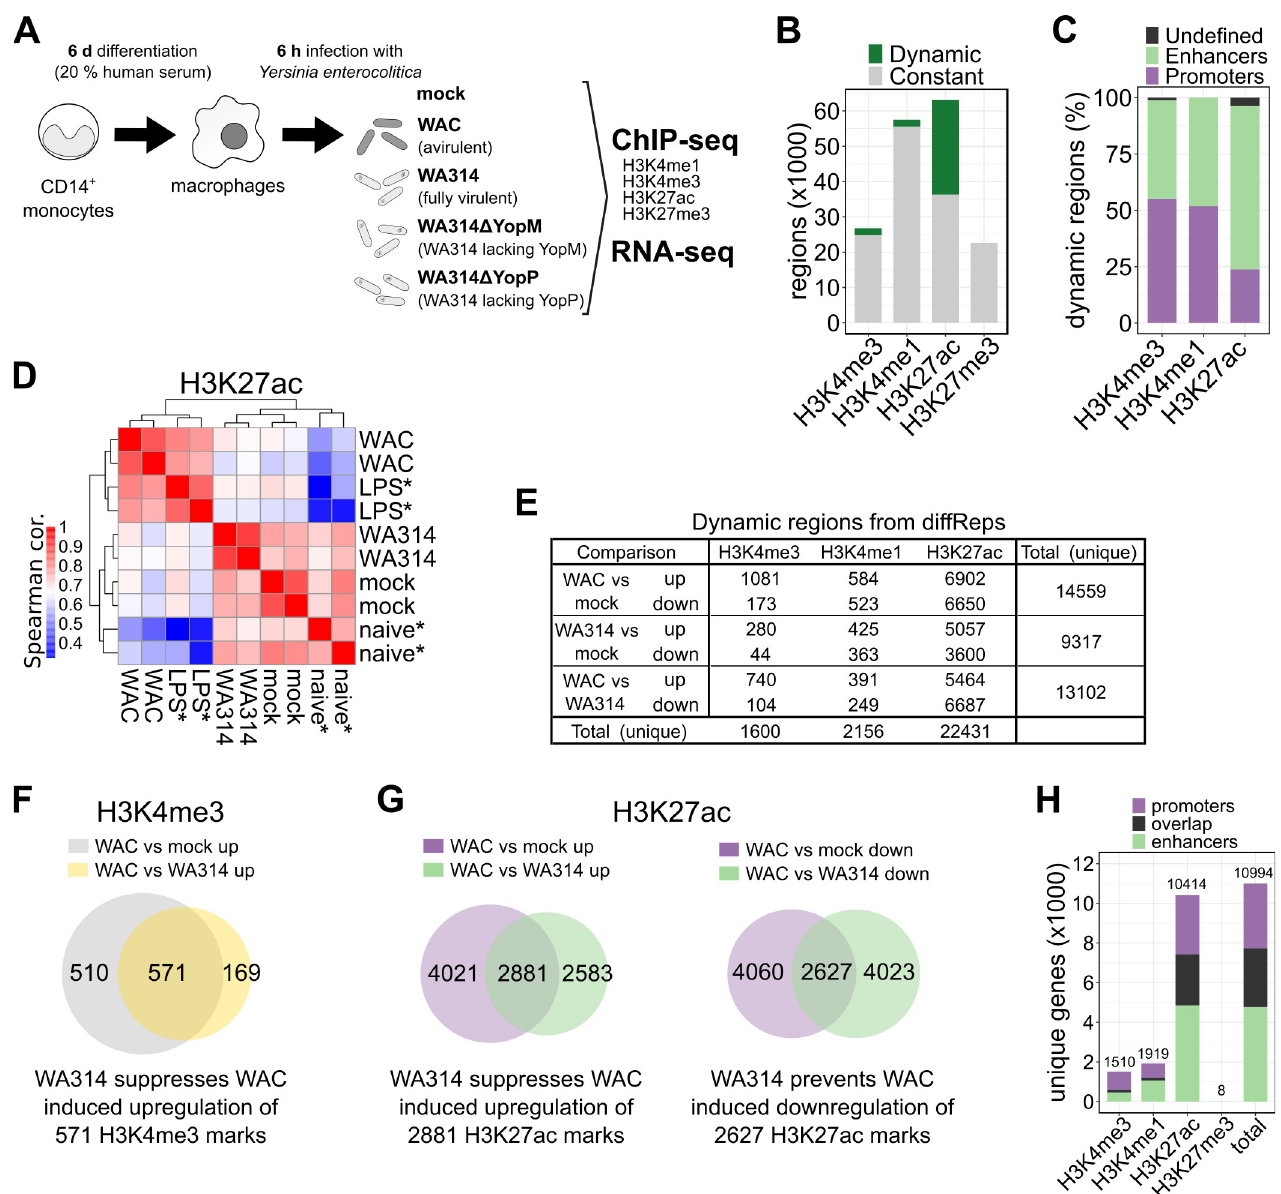
Fig 1. Changes of epigenetic histone modifications in Y . enterocolitica infected primary human macrophages. A, Experimental design. CD14 + monocytes were isolated and differentiated into macrophages by cultivation with 20% human serum for 6 days. Macrophages from � two independent donors were mock infected or infected with avirulent Y . enterocolitica strain WAC, wild type strain WA314 or the single Yop-mutant strains WA314 Δ YopM and WA314 Δ YopP with multiplicity-of-infection (MOI) of 100 for 6 h. Samples were subjected to ChIP-seq for histone modifications H3K27ac, H3K4me3 and RNA-seq. H3K4me1 and H3K27me3 ChIP-seq was performed only for mock, WAC and WA314 infected macrophages. For all replicates used in the analysis see S17 Table. B, Bar plot showing proportions of dynamic and constant regions of ChIP-seq data obtained from mock-, WAC- and WA314 infected macrophages as described in (A) . Dynamic regions were defined as MACS (H3K4me3, H3K27ac) or SICER (H3K4me1, H3K27me3) peaks overlapping significantly ( � 2-fold change, adjusted P-value � 0.05) up- or down-regulated differentially enriched regions from diffReps in the three pairwise comparisons WAC vs mock, WA314 vs mock and WAC vs WA314. C, Bar plot showing distribution of dynamic regions from (B) at gene promoters and enhancers. D, Heatmap showing Spearman correlation (cor.) of H3K27ac tag density at all H3K27ac peaks from mock-, WAC- and WA314-infected samples and publicly available H3K27ac ChIP-seq data of naive � and LPS � treated macrophages. Low to high correlation is indicated by blue-white-red colour scale. E, Number of differentially enriched regions (diffReps � 2-fold change, adjusted P-value � 0.05) for the indicated histone marks. Total (unique) refers to all unique regions in each row or column after merging overlapping regions. F, G, Venn diagrams showing overlaps of differentially enriched regions from diffReps depicting suppression of WAC induced upregulation of H3K4me3 marks by WA314 (F) and suppression of WAC induced up-regulation of H3K27ac marks by WA314 or prevention of WAC induced down-regulation of H3K27ac marks by WA314 (G) . H, Bar plot showing the number of genes associated with promoters, enhancers or both for the indicated histone marks associated with dynamic regions in (E) or when taking all regions together (total).